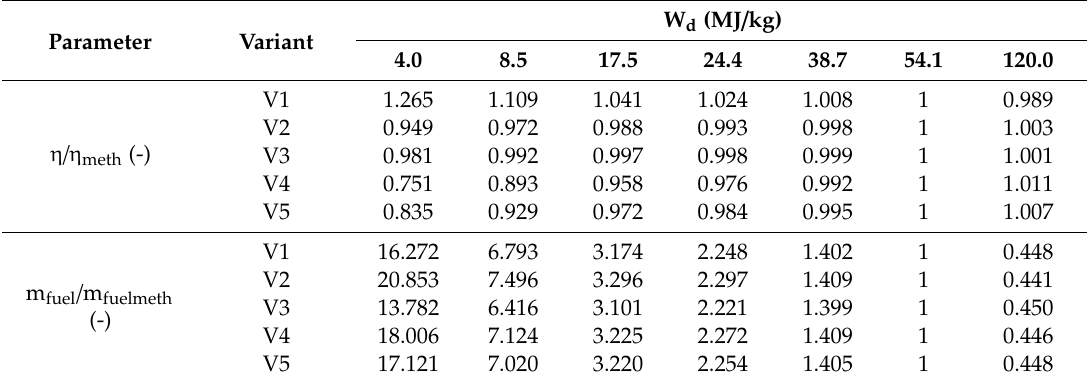
Table 3. Selected calculation